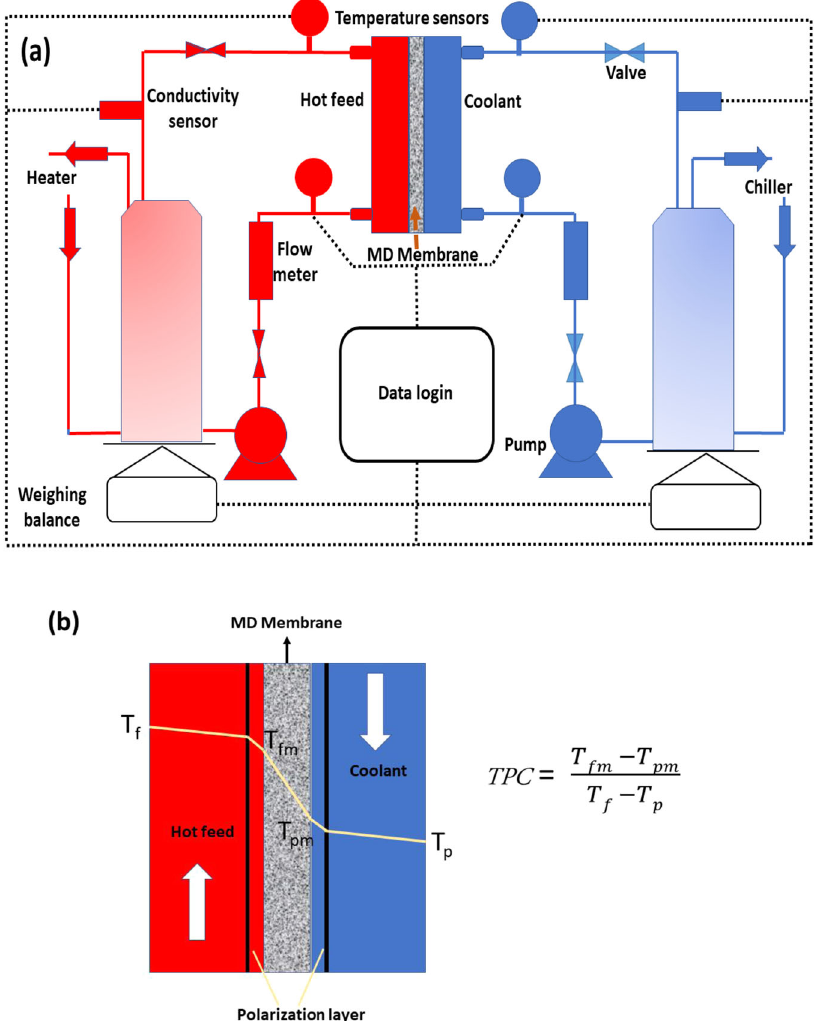
Fig. 6 Direct contact membrane distillation (DCMD) process. a Schematic representation of experimental DCMD setup, and b the TP pro fi le in a DCMD